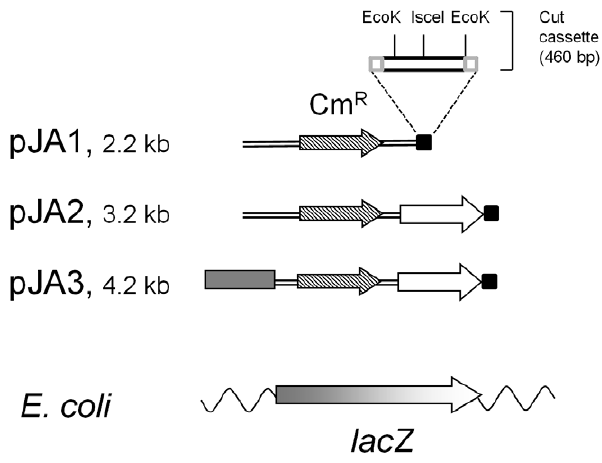
Figure 2. Maps of plasmids pJA1, pJA2 and pJA3 after linearization in the cut cassette. The 1 kb 5 9 part of lacZ is shown with a grey box, and the 1 kb 3 9 part of lacZ (lacZend) by a white arrow. The cat gene encoding resistance to chloramphenicol (Cm R ) is shown as a stripped arrow. The cut cassette is indicated by a small black box, linearization of pJA plasmids in vivo might happen either at the IsceI recognition sequence, or between the two Eco K sites. The cut cassette map is shown in details, with two grey boxes indicating the Chi sites. Below the three plasmids, the E. coli chromosome with which plasmids might recombine is shown (wavy line) in the lacZ region (grey to white arrow).